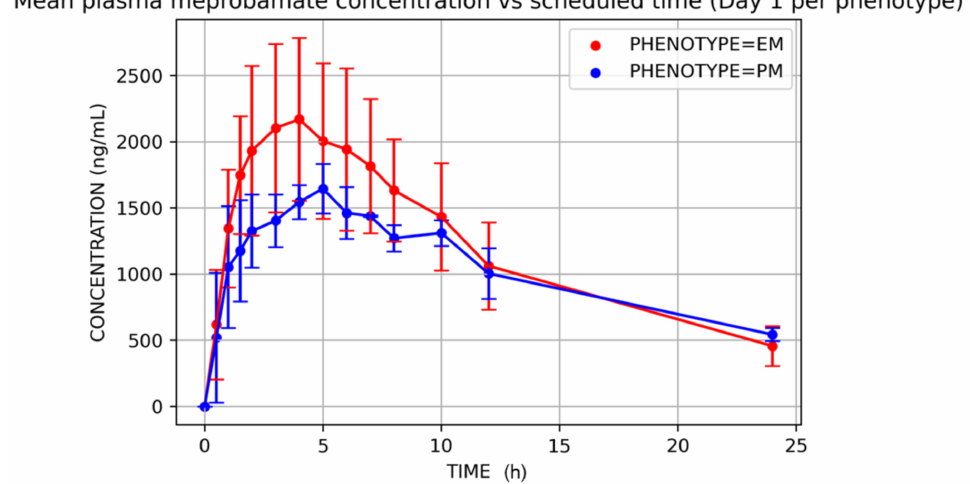
Figure 6. Mean plasma meprobamate concentration vs. time, D1, by phenotype. EM = extensive metabolizer; PM = poor